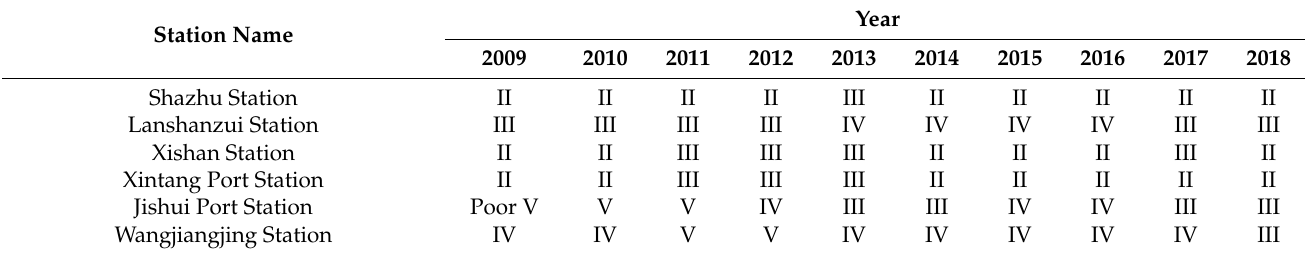
Table 2. Water quality evaluation results based on the one-factor evaluation method.